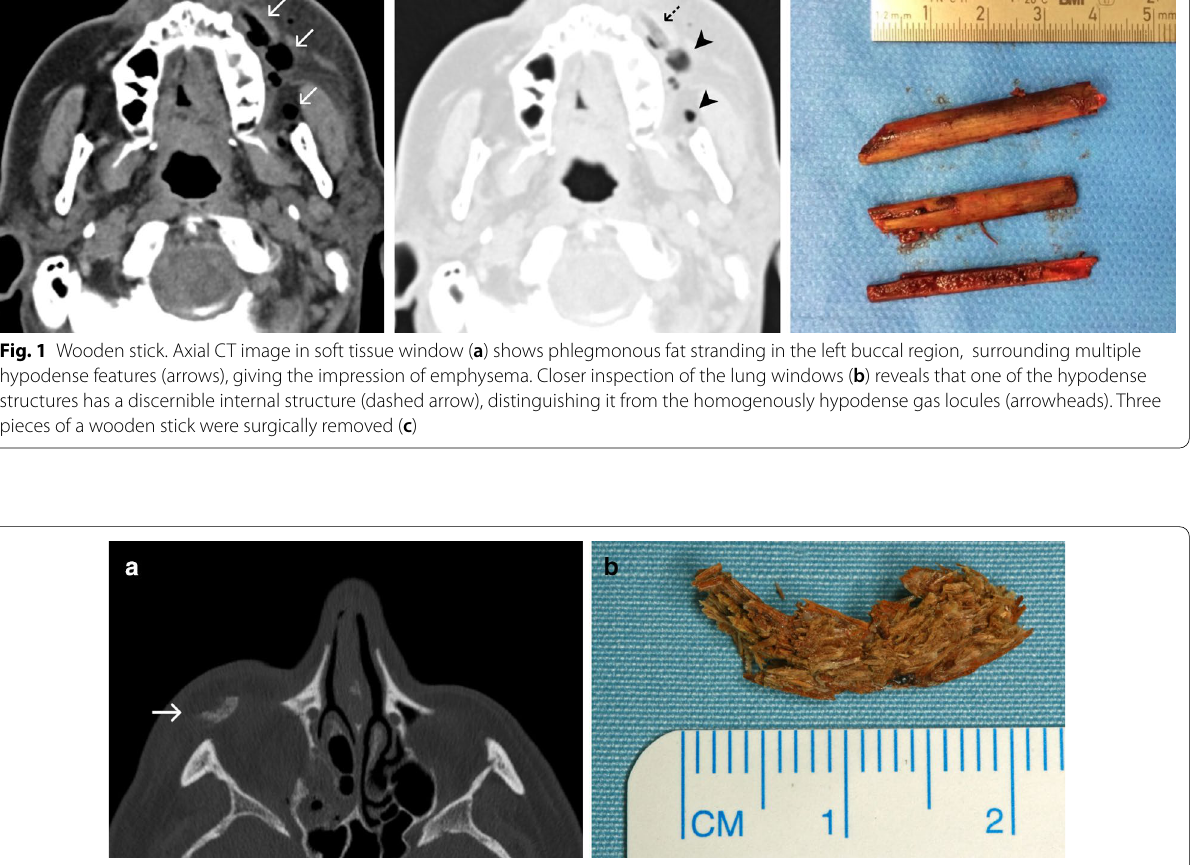
Fig. 2 Chipboard wood. a An axial CT image displaying a hyperdense structure dislocated in periorbital soft tissues inferior and anterior to the right globe (arrow). Hyperdensity of the foreign object in this case is likely due to its industrial processing. b A photograph of a chipboard fragment after its removal from the soft